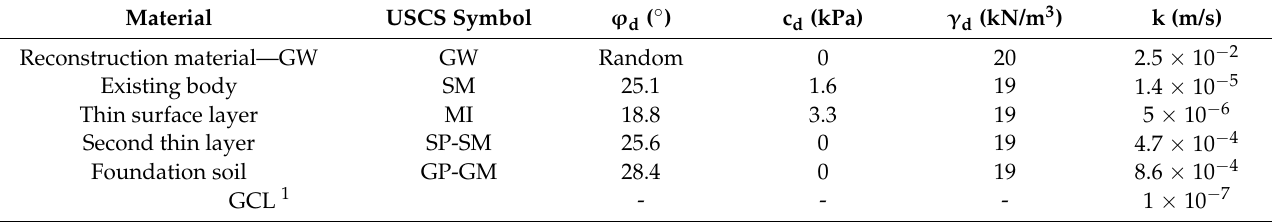
Table 2. Deterministic values of parameters.